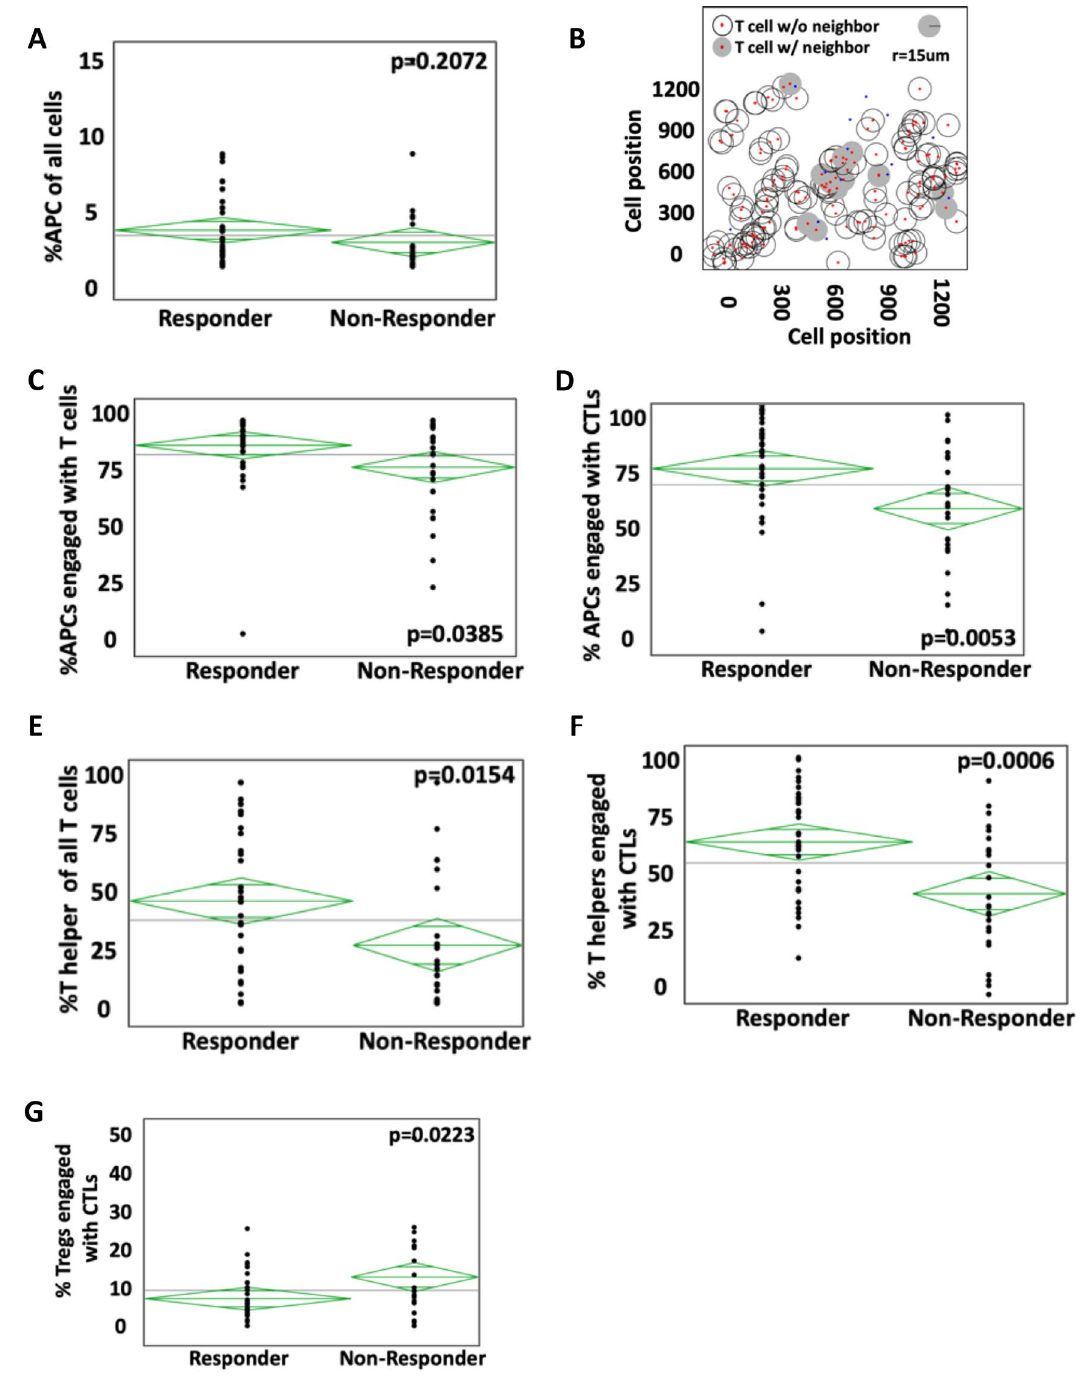
Figure 2. Interactions of antigen presenting cells (APCs) and helper T cells (HTLs) with cytotoxic T cells (CTLs) in responders and non-responders. ( A ) Percentage of all cells that are APCs in responders versus non responders. ( B ) Example of mathematical measurement of CTLs with and without neighbors, by using a 15 μm radius as defining engagement. ( C ) Percentage of APCs engaged with T cells in responders compared to non- responders. ( D ) Percentage of APCs engaged specifically with CTLs. ( E ) Percentage of all T cells that are HTLs in responders versus non responders. ( F ) Lower engagement of HTL to CTL in non-responders compared to responders. ( G ) Higher engagement of regulatory T cells (Tregs) with CTL in non-responders compared to